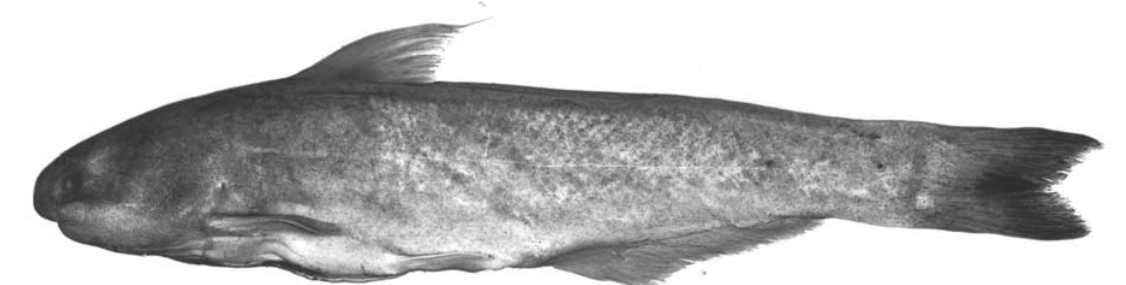
Fig. 28. Cetopsis motatanensis, paratype of Pseudocetopsis plumbeus motatanensis , female, USNM 121268, 155 mm SL; Venezuela, Trujillo, río Motatán, 4 km below Motatán (approximately 9°24’N,